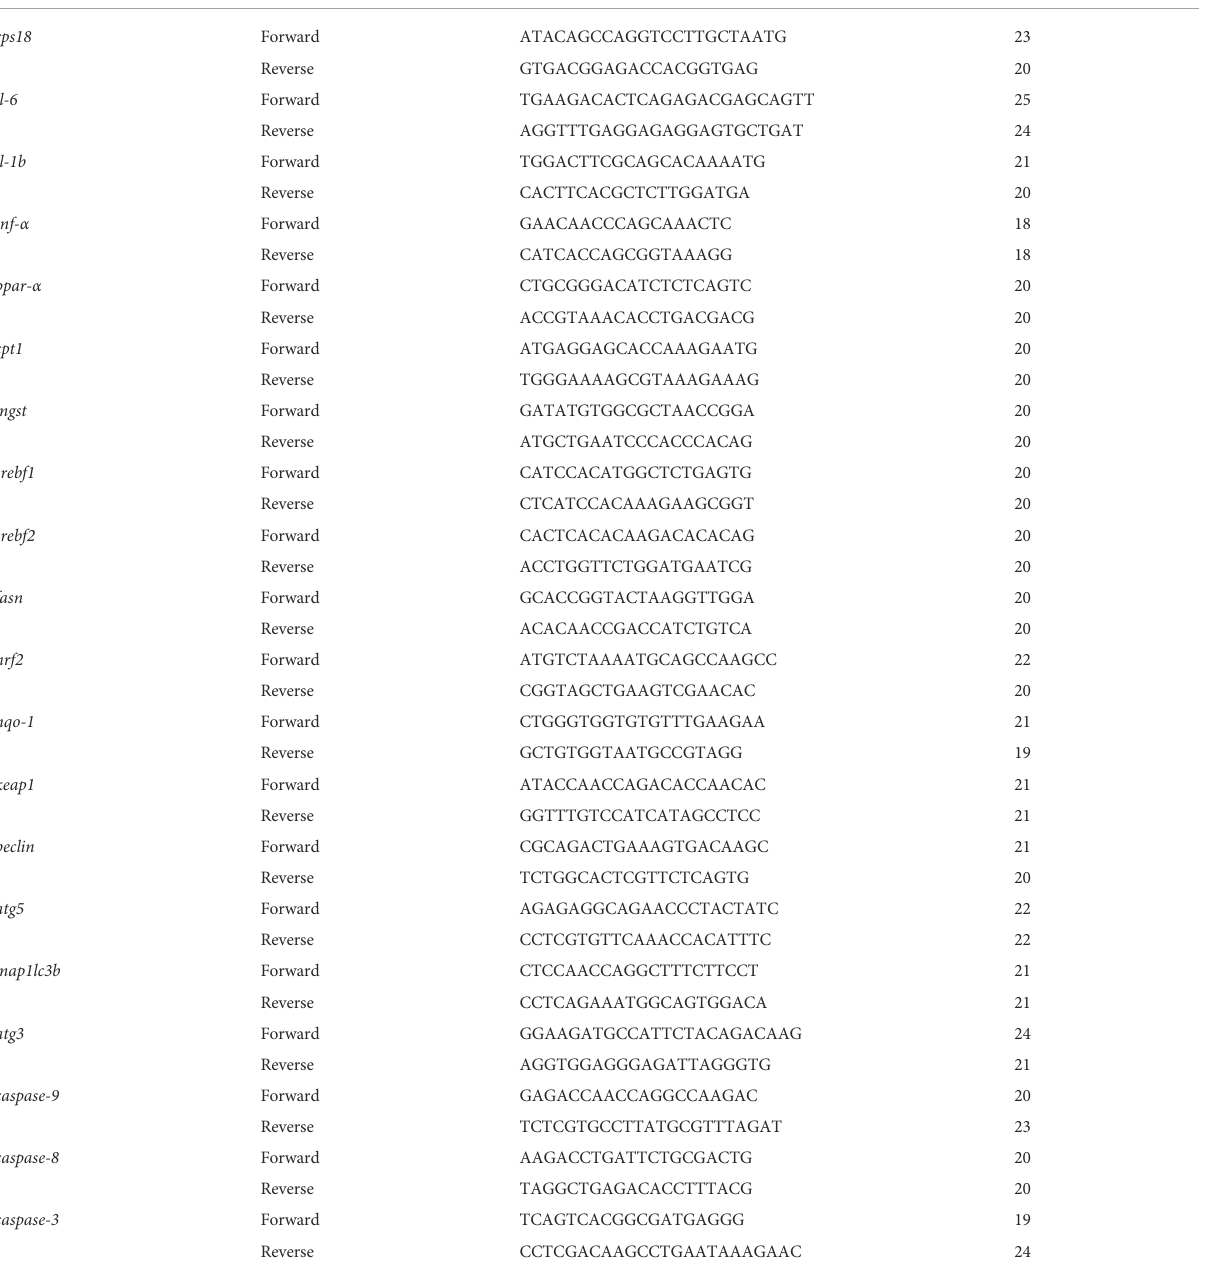
TABLE 1 The gene Primers for Quantitative Real-time